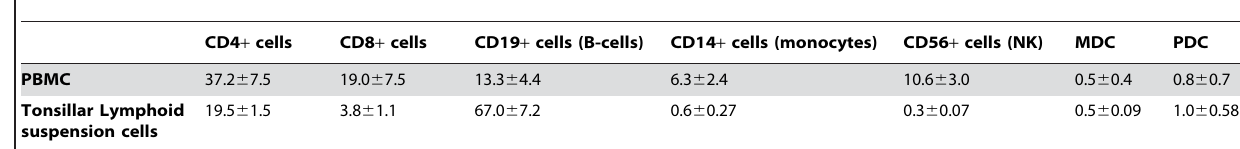
Table 1. Differential cell count in PBMC and tonsillar lymphoid suspension cells in % (avg 6 std; n=4).